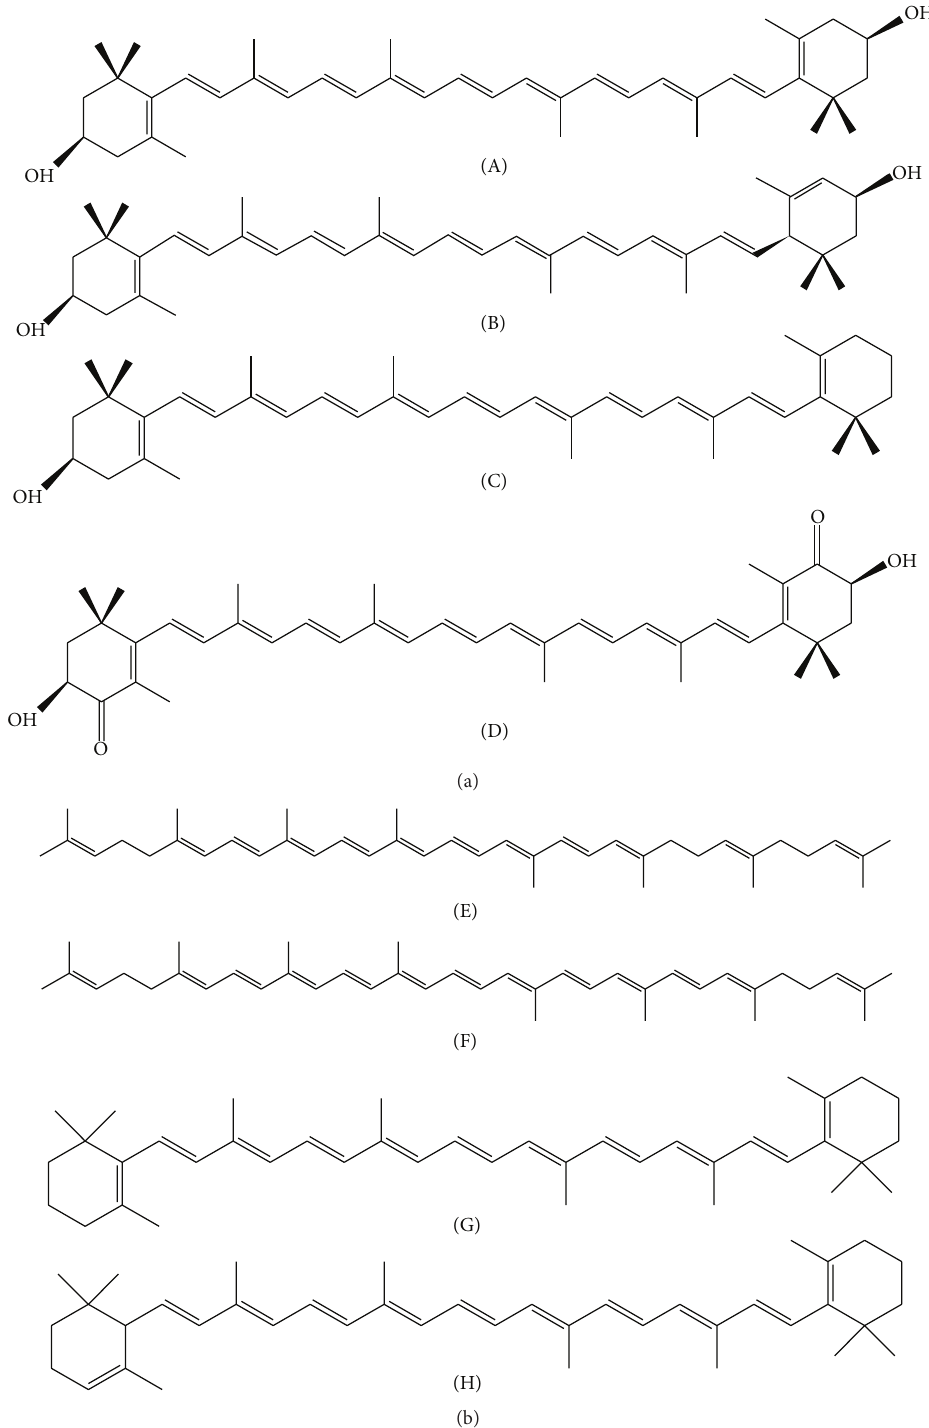
Figure 2: Carotenoids structure: (a) xanthophylls: (A) zeaxanthin, (B) lutein, (C) beta-cryptoxanthin, and (D) astaxanthin; (b) Carotenes: (E) neurosporene, (F) lycopene, (G) 𝛽 -carotene, and (H) 𝛼 -carotene. Reference: Britton et al.